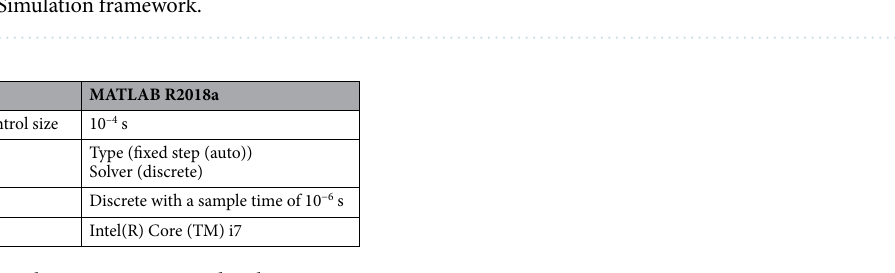
Table 3. Simulation environment